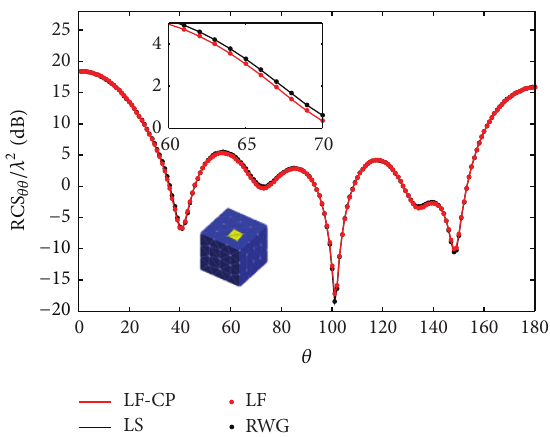
Figure 9: BiRCSs of the PEC almond. (a) 1GHz and (b) 70